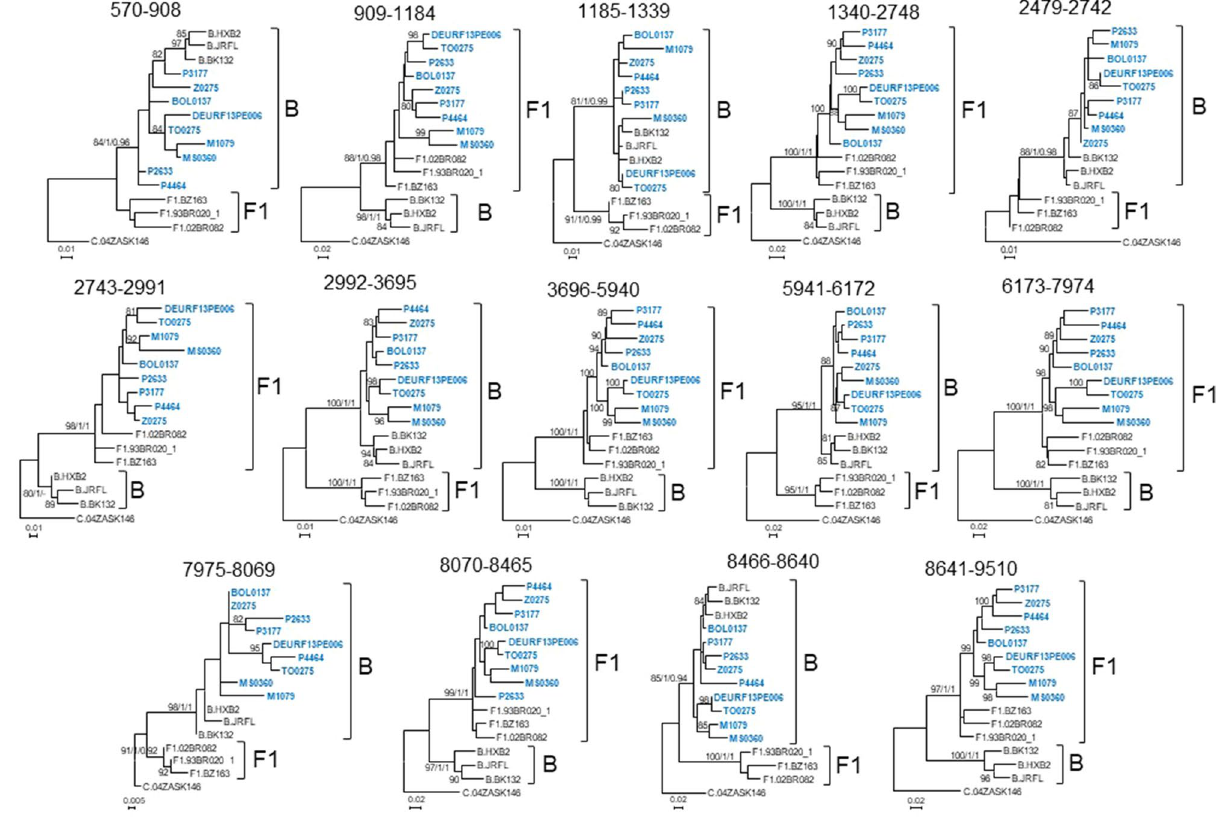
Figure 4. Phylogenetic trees of genome segments of the BF cluster. HXB2 positions delimiting the analyzed segments are indicated on top of the trees. Sequence names of viruses of the BF cluster are in blue. Names of subtype references are preceded by the corresponding subtype. Node supports of B and F1 clades are indicated, in this order, as ultrafast bootstrap value/aLRT SH-like support/posterior probability, which were obtained with IQ-Tree, PhyML, and MrBayes programs, respectively. For the other nodes, only ultrafast bootstrap values are indicated. Only bootstrap values ≥ 80%, aLRT SH-like values ≥ 0.9, and posterior probabilities ≥ 0.9 are